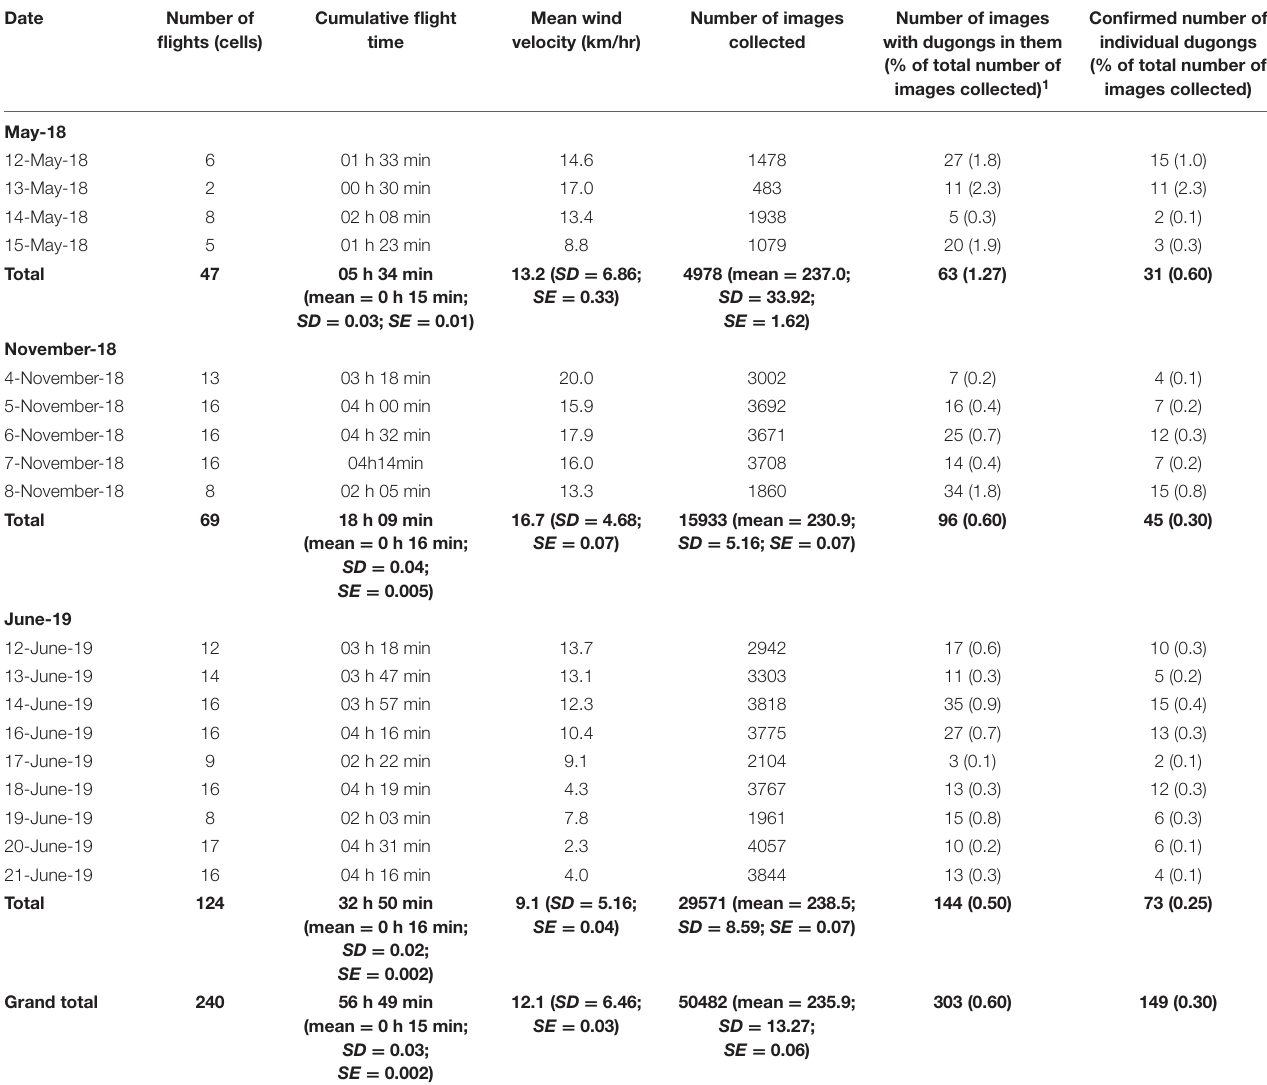
TABLE 2 | UAV flight and image count details for all surveys conducted at the Exmouth Gulf site. Number of Cumulative flight Mean wind Number of images Number of images flights (cells) time velocity (km/hr) collected with dugongs in them (% of total number of images collected) 1